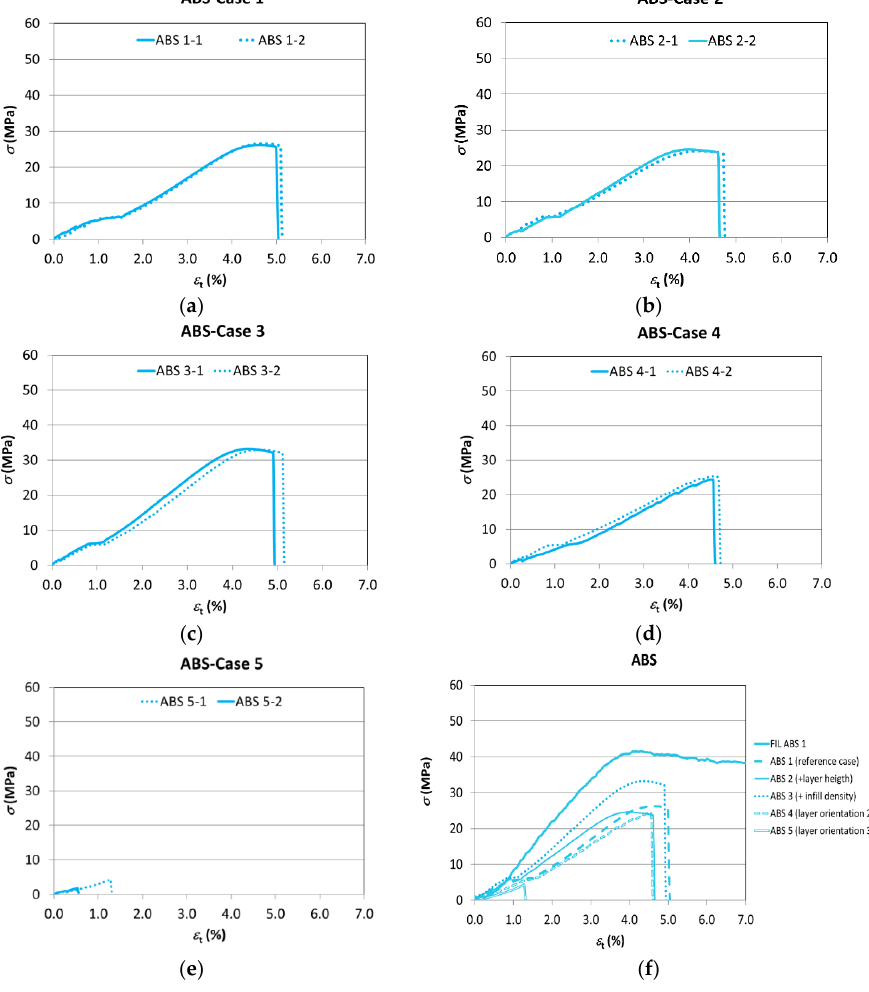
Figure 11. The stress – strain curves (ABS). ( a ) Case 1; ( b ) Case 2; ( c ) Case 3; ( d ) Case 4; ( e ) Case 5; ( f ) The comparison of the results with the intermediate values of each series of test specimens. The data corresponding to the yield stress, tensile strength, nominal strain at break, and modulus of elasticity are shown in Table 8. Table 8. The mechanical properties of the ABS test specimens and variation with respect to the benchmark case (Case 1).